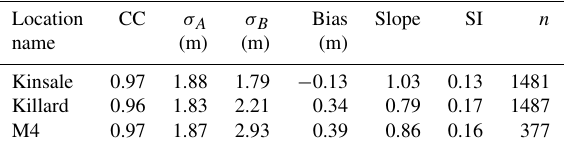
Table 1. Statistical